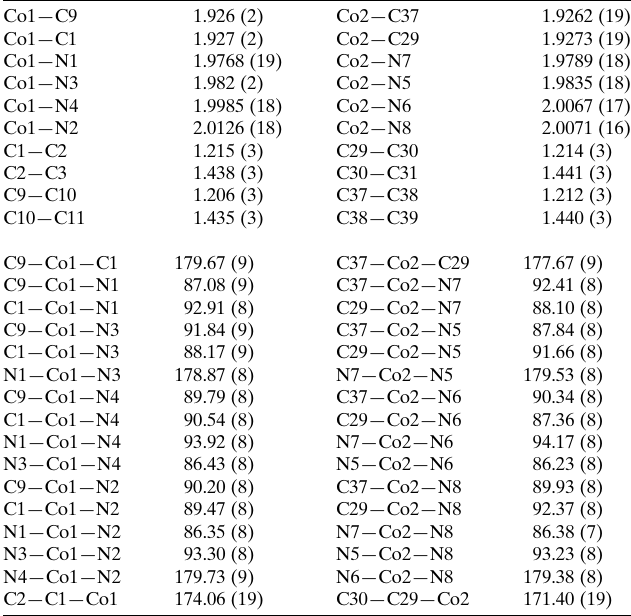
Table 2 Selected geometric parameters (A˚ , (cid:3) ) for 2